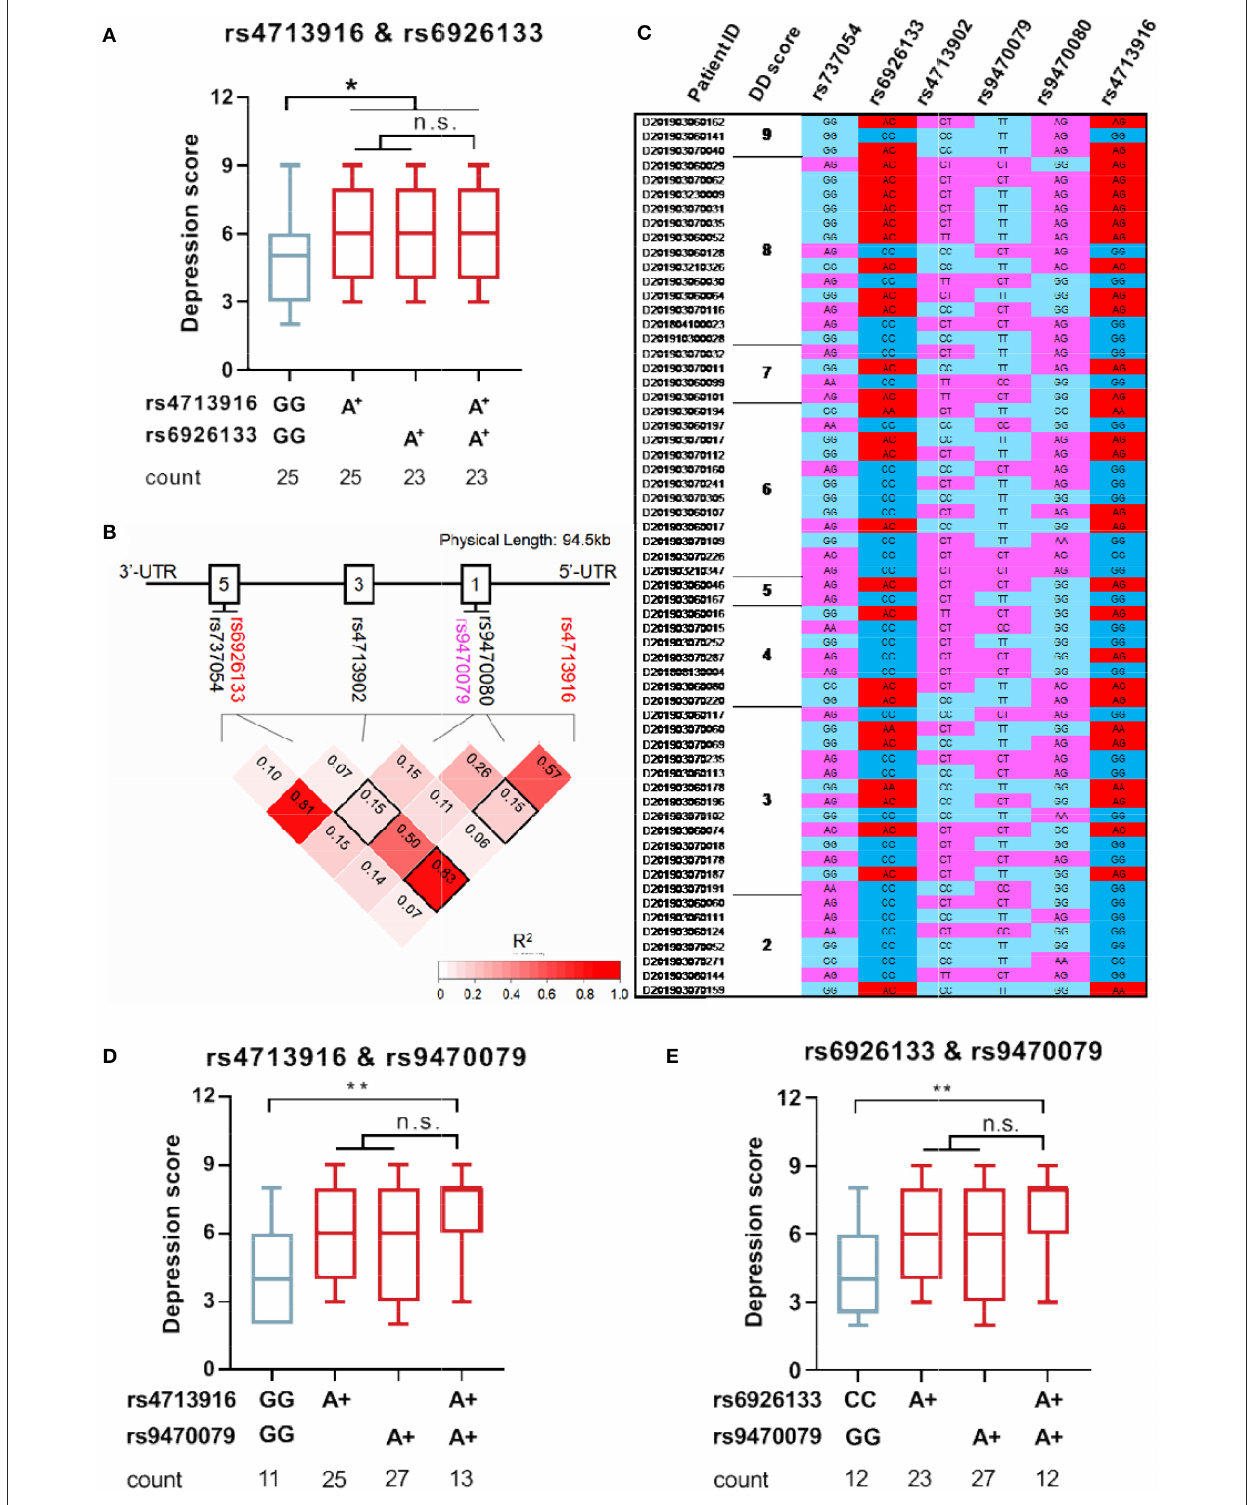
FIGURE4 FKBP5 risk alleles rs4713916A and rs6926133A can serve as biomarkers of severe DD in patients with MAUD. (A) Depression status in the individuals carrying FKBP5 rs4713916A and/or rs6926133A risk alleles. *p < 0.05; n.s., no significance; Kruskal–Wallis test. (B) The chromosomal location of the six FKBP5 SNPs on chromosome 6 is shown by the X-axis. The location distance is 94.5kb. The intron structure of the gene is depicted as empty boxes on the top. The numbers in the pairwise LD block squares are R 2 values. Complete LD (R 2 = 1) and no LD (R 2 = 0) are shown in red and white, respectively. Analysis was performed on 282 people. FKBP5 rs4713916 and rs6926133 had R 2 values of 0.83 and were in strong LD. (C) The exhibition of DD scores and SNP information in 50 patients with MAUD. MAUD, methamphetamine use disorder; DD, depressive disorder; LD, linkage disequilibrium. (D) Depression status in the individuals carrying FKBP5 rs4713916A and/or rs9470079A risk alleles. *p < 0.05; n.s., no significance; Kruskal-Wallis test. (E) Depression status in the individuals carrying FKBP5 rs6926133A and/or rs9470079A risk alleles. *p < 0.05; n.s., no significance; Kruskal-Wallis